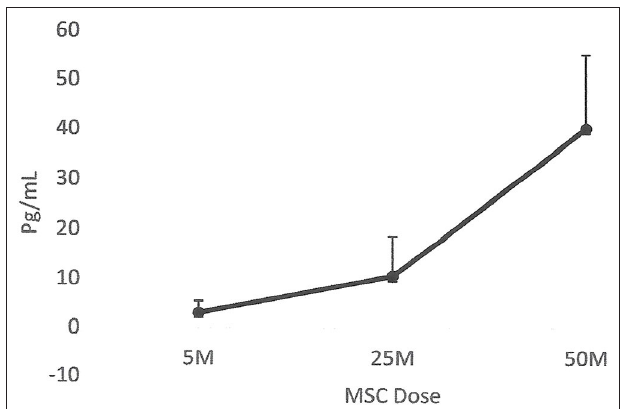
FIGURE 6 | Correlation between serum IL-10 and MSC dose. The data showed that the level of IL-10 in peripheral blood 90 days after intra-articular administration of various doses of MSCs increased in a dose dependent manner. However, due to the small sample size, the difference was not significant ( P =